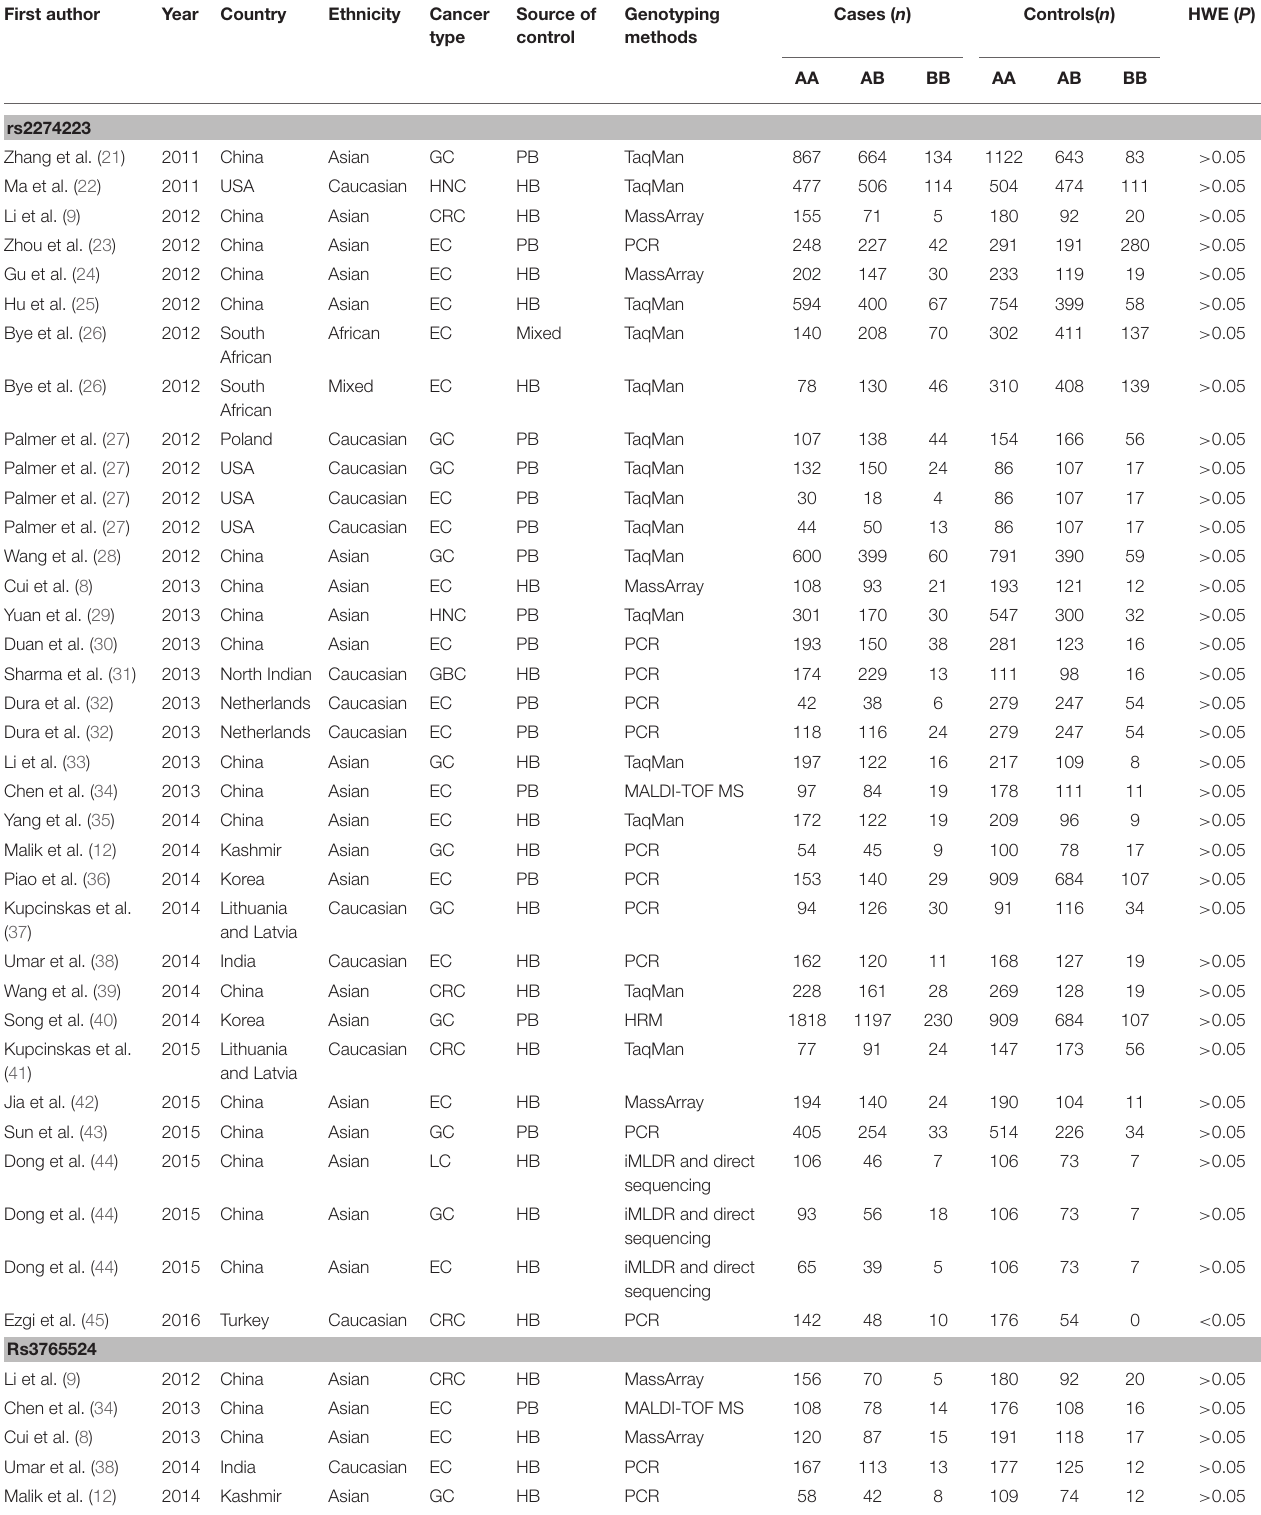
TABLE 1 | Characteristics of